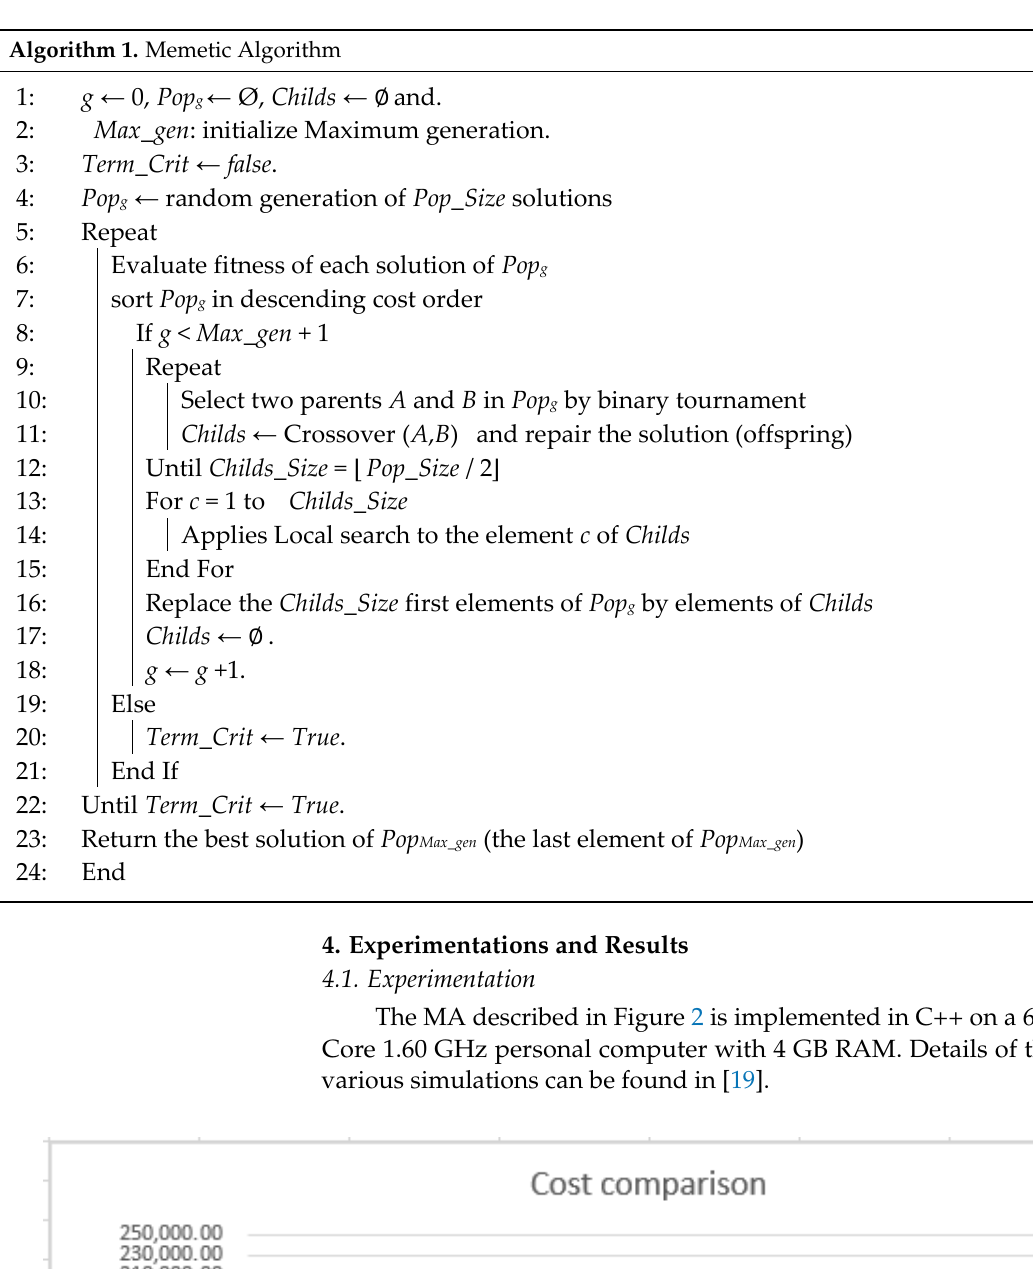
Figure 3. Computation time comparison. Figure 4 shows a general evolution of the MA algorithm for EDPRP like the one presented by [34,51]. In this figure, instances (1), (2), (3), and (4) are representative of the four classes of instances used to conduct tests on the dataset. These instances consisting of 40 clients ( n = 40), six periods ( l = 6), and three vehicles highlight the general behavior